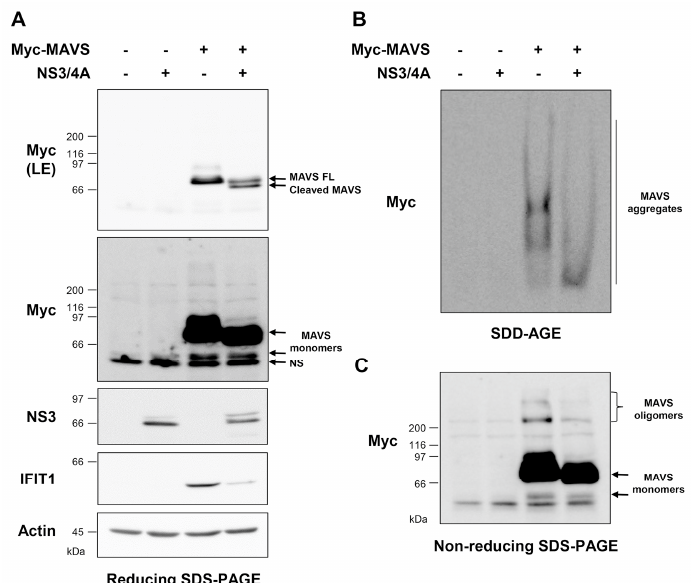
Figure 4. Impact of NS3/4A-mediated cleavage on the formation of MAVS polymer species. HEK293 cells were co-transfected with plasmids encoding NS3/4A and Myc-tagged MAVS (Myc-MAVS) or the corresponding empty vectors. At 24 h post-transfection, cells were harvested, lysed, and the WCEs were immediately subjected to reducing SDS-PAGE ( A ); SDD-AGE ( B ) or non-reducing SDS-PAGE ( C ). Proteins were detected by immunoblot using anti-actin, anti-Myc, anti-IFIT1, or anti-NS3 antibodies. In ( A ), in addition to the exposure of the anti-Myc immunoblot corresponding to the exposure of panel ( C ), a lower exposure is shown for appropriate appreciation of the MAVS cleavage by NS3/4A. NS: non-specific.